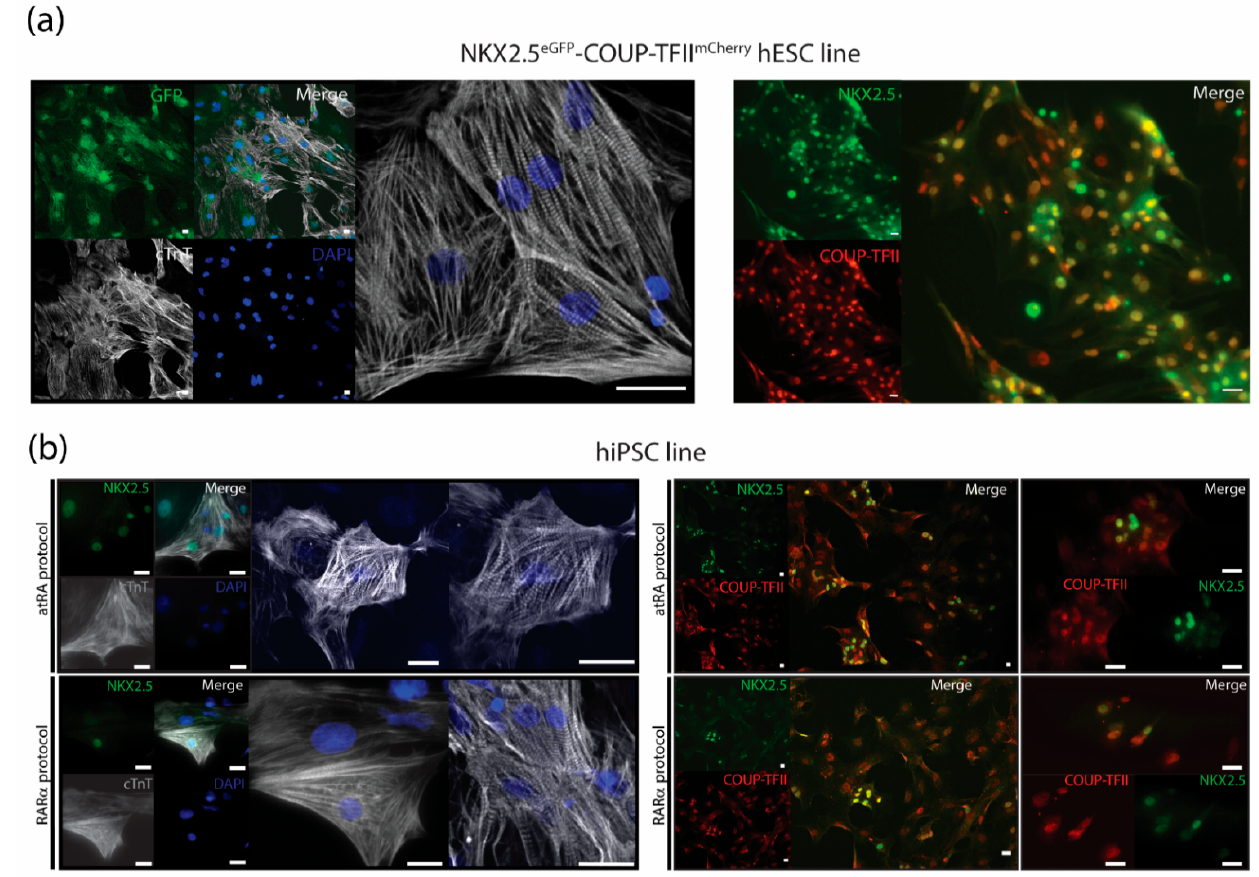
Figure 4. Immunostainings for characterization of AMs. ( a ) Cardiac troponin T (cTnT) together with endogenous NKX2.5-GFP and nuclear stain DAPI with representative pictures of immunostainings for COUP-TFII together with NKX2.5 in RAR α -treated AMs at day 21 in unsorted cultures after dissociation and re-plating. Scale bar = 25 µm. ( b ) Representative pictures of immunostainings for cardiac troponin T (cTnT) together with NKX2.5 and nuclear stain DAPI and immunostainings of COUP-TFII together with NKX2.5 of atRA and RAR α -treated, hiPSC-derived AMs in sorted cultures at day 21. Scale bar = 25 µ